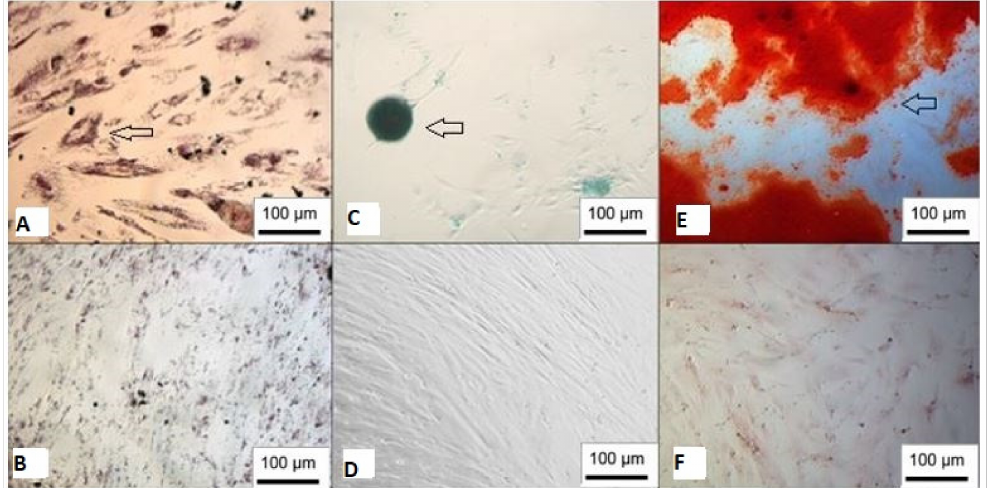
Figure 4. Trilineage differentiation of UCB-MSC. ( A ) Adipocytes stained with Oil Red O; ( B ) undiffer- entiated control; ( C ) chondroblasts stained with Alcian Blue; ( D ) negative control; ( E ) cells showing mineralization stained with Alizarin Red; ( F ) undifferentiated control (inverted optical microscopy, × 100). Scale bar, 100 µ